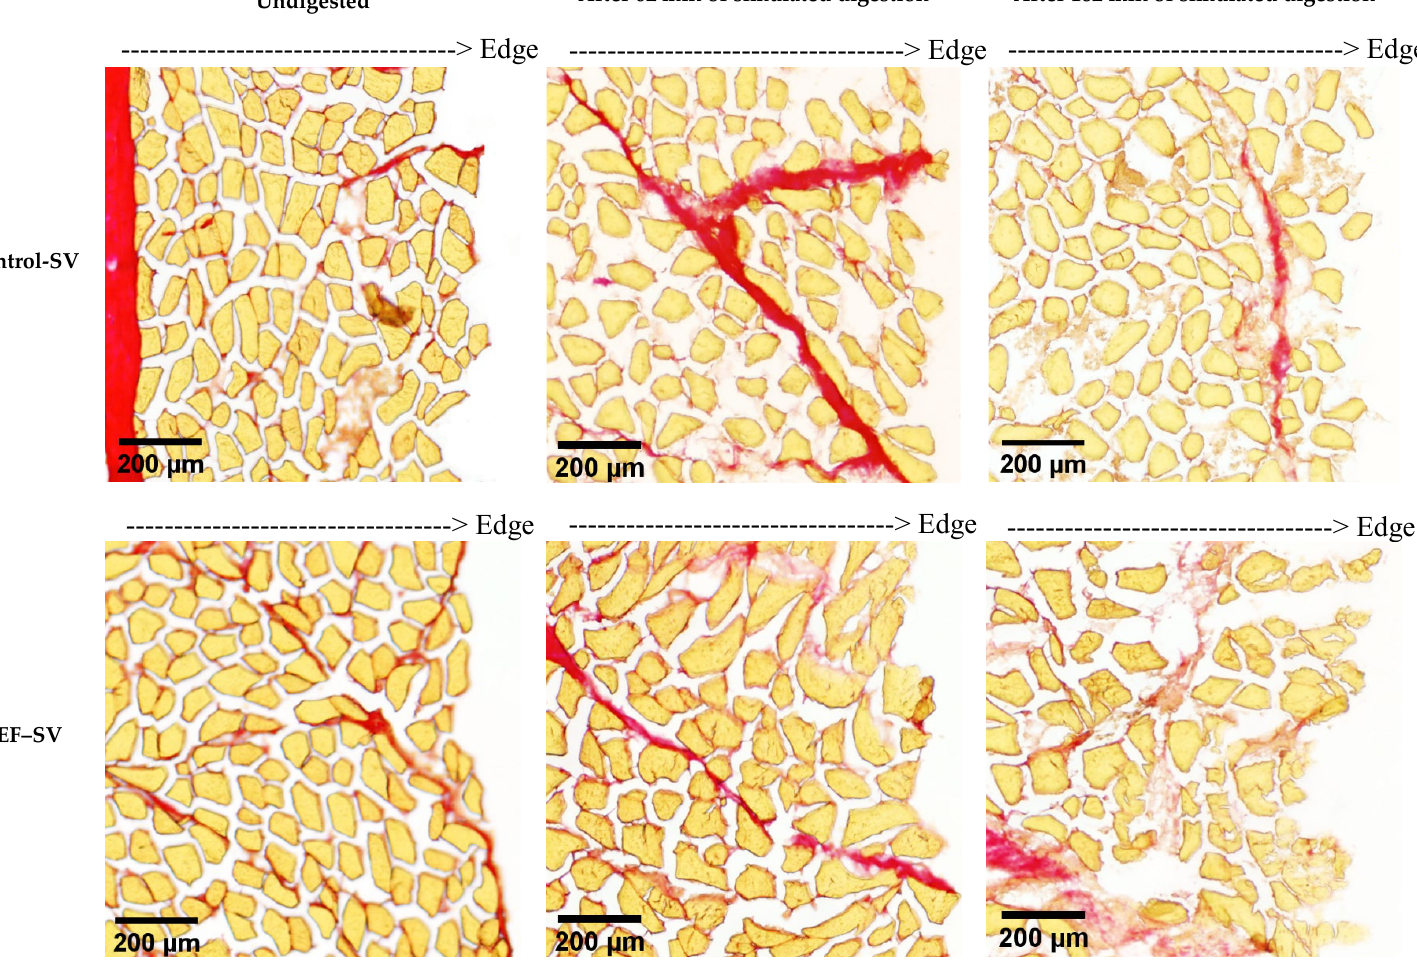
Figure 3. Histological sections of the control sous vide (SV)-cooked and the pulsed electric field (PEF)-treated SV-cooked meat at different digestion time points, showing more severe structural degradation of PEF-treated meat by the digestive enzymes at the end of simulated digestion. Connective tissue (in red) was stained with Sirius Red dye and muscle cells (in yellow) were stained with picric